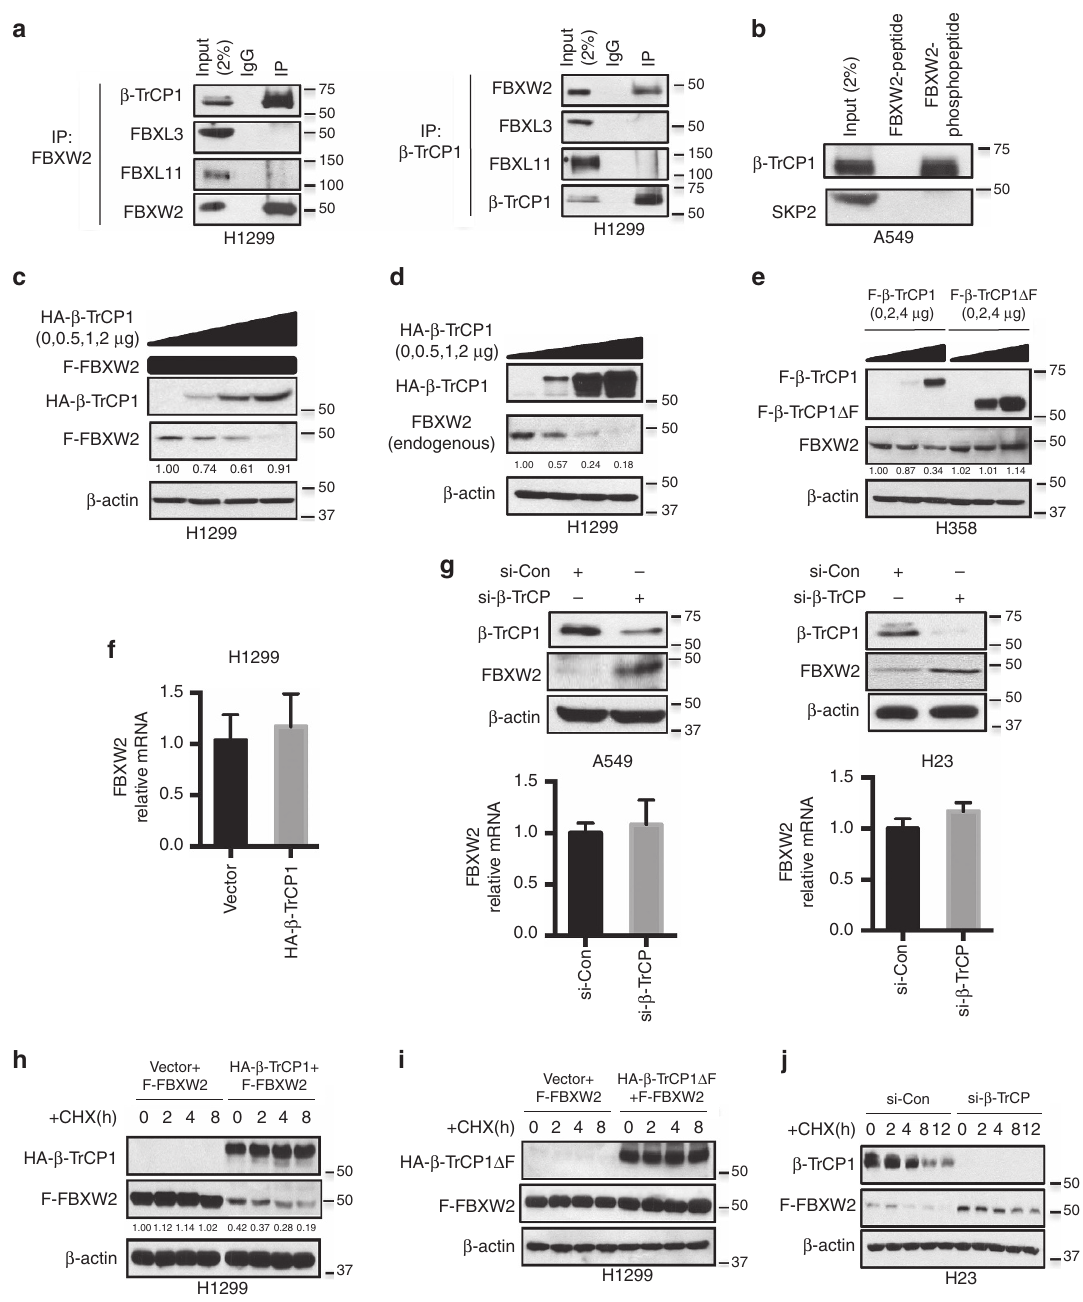
Figure 1 | b -TrCP1 binds to FBXW2 and negatively regulates FBXW2 levels. ( a ) b -TrCP1 binds to endogenous FBXW2: Cell lysates from H1299 cells were pulled down with anti-FBXW2 or anti- b -TrCP1 Abs, followed by IB with indicated Abs. ( b ) b -TrCP1 binds to phosphor-FBXW2 peptide: Cell lysates from A549 cells were incubated with bead-conjugated FBXW2 non-phosphorylated or phosphor-peptide containing b -TrCP binding motif. Beads were washed and subjected to IB with indicated Abs. ( c – e ) Overexpression of b -TrCP1, but not its D F mutant, decreases the levels of FBXW2 protein: H1299 and H358 cells were co-transfected with F-FBXW2 (FLAG-tagged FBXW2) and increasing amounts of b -TrCP1, or transfected with increasing amounts of b -TrCP1 or b -TrCP1 D F alone, followed by IB with indicated Abs. The band density was quantified. ( f ) b -TrCP1 overexpression has no effect on FBXW2 mRNA: H1299 cells were transfected with b -TrCP1 or vector control, followed by qRT-PCR for mRNA expression. Error bars indicate mean þ s.d. of three repeats. ( g ) b -TrCP silencing increases the endogenous levels of FBXW2 protein, but not mRNA: A549 and H23 cells were transfected with siRNA targeting both b -TrCP1 and b -TrCP2, along with scrambled siRNA, followed by IB (top panels) or qRT-PCR (bottom panel). Error bars indicate mean þ s.d. of three repeats. ( h , i ) FBXW2 half-life is shortened by b -TrCP1, but not by b -TrCP1 D F: FLAG-FBXW2 was transfected into H1299 cells, along with the vector control or plasmid expressing HA- b -TrCP1 or HA- b -TrCP1 D F. Cells were switched to fresh medium (10% FBS) containing cycloheximide (CHX) 48h post transfection for indicated time periods and harvested for IB. The band density was quantified. ( j ) b -TrCP1 RNAi silencing extends protein half-life of endogenous FBXW2. H23 cells were transfected with either control RNAi, or RNAi targeting both b -TrCP1 and b -TrCP2 for 48h. Cells were cultured in fresh medium containing CHX and incubated for indicated time periods before being harvested for